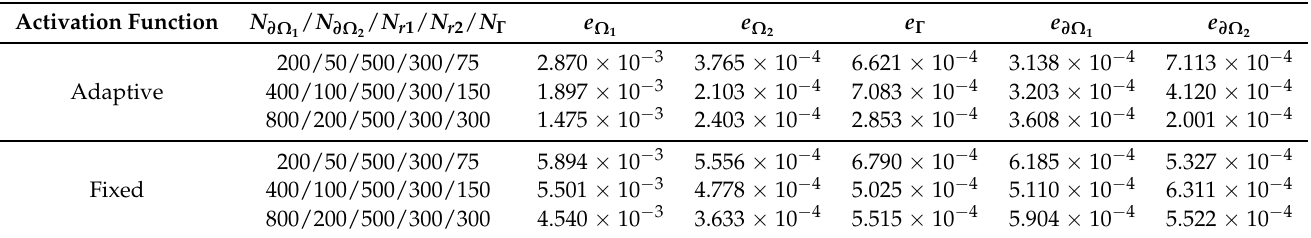
Table 5. Comparison of errors by adaptive and fixed activation function strategies with different numbers of training points for Example 3.